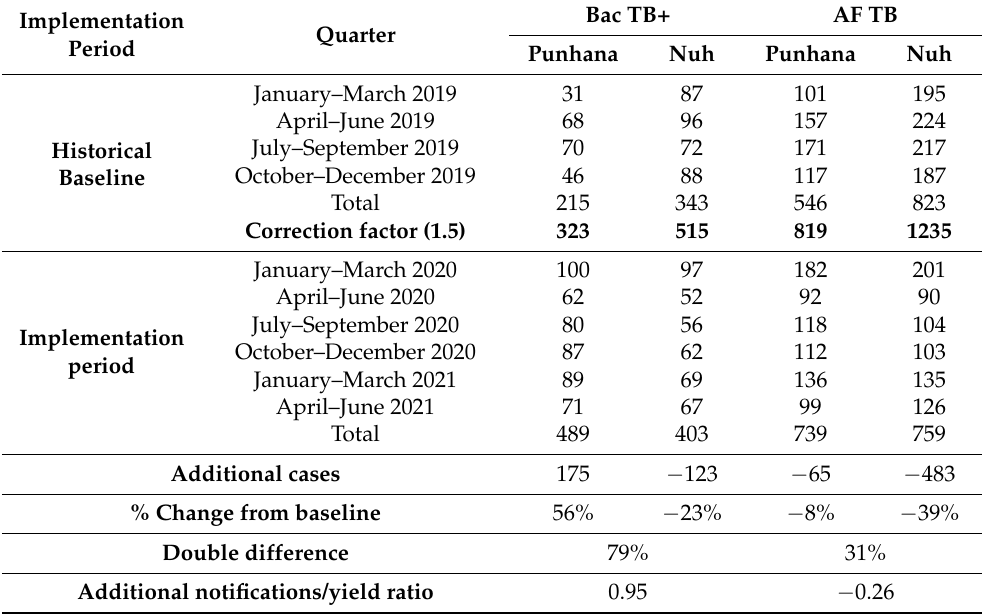
Table 6. Comparison between TB case notification during historical baseline and implementation period in Punhana (EP) and Nuh (CP)